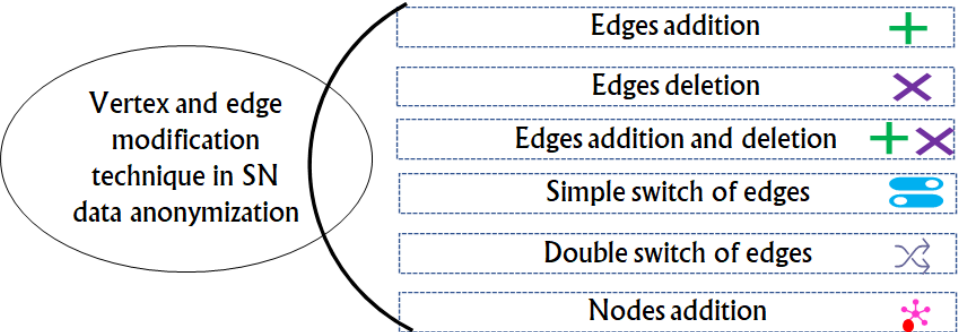
Figure 14. Overview of graph modification methods. (adopted from